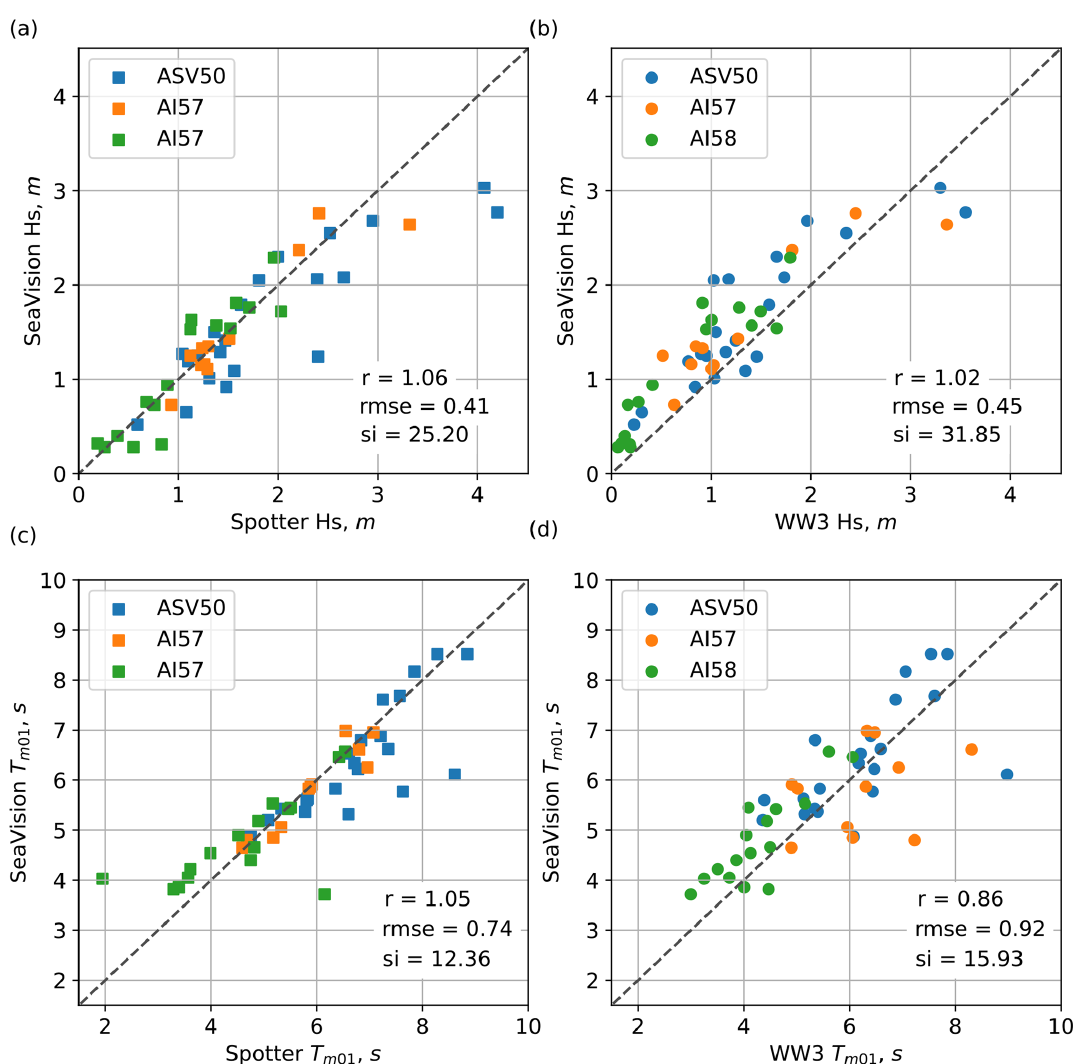
Figure 6. Scatterplots of the significant wave height ( H s ) and wave period ( T m01 ) revealed by SeaVision and measured by Spotter (a, c) as well as revealed by SeaVision and simulated with WaveWatch III (WW3, b , d ) for all stations, together with root mean square error (RMSE) and scatter index (SI)